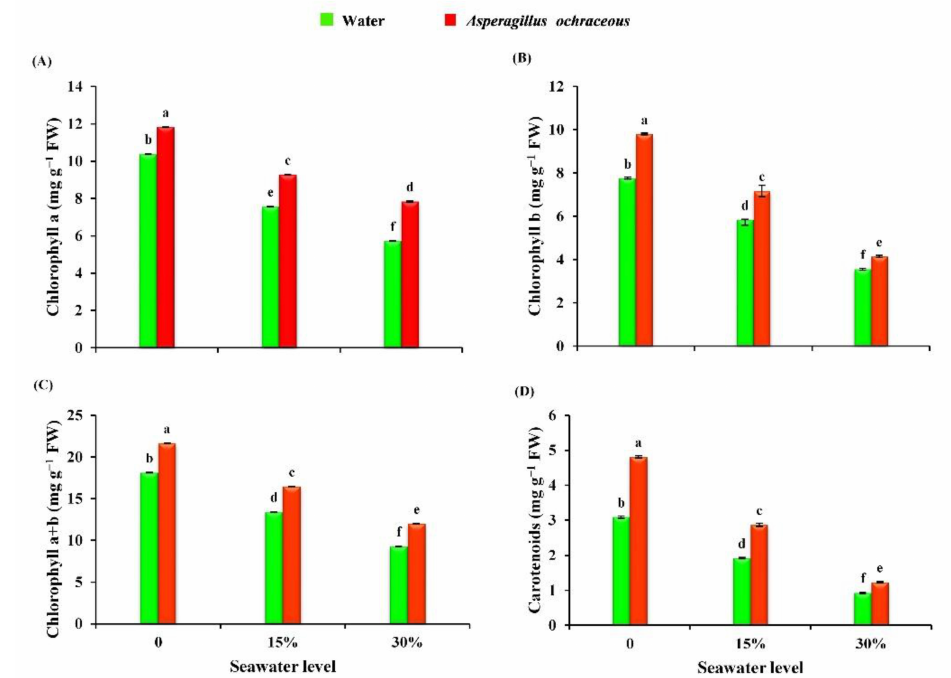
Figure 5. Effect of seawater irrigation, A. ochraceus application, and their interactions on leaf pigments of barley plants {( A ) chlorophyll a, ( B ) chlorophyll b, ( C ) chlorophyll a + b, and ( D ) carotenoids}. Each bar represents the mean ± standard error. Different letters indicate significant differences between the treatments according to an LSD test at p < 0.05. FW: fresh weight. Table 3. Effect of seawater irrigation, A. ochraceus application, and their interactions on soluble sugars, soluble proteins, and free proline contents (mg g − 1 DW) in barley plants. Each value represents the mean ± standard error. Different letters indicate significant differences between the treatments according to an LSD test at p < 0.05. DW: Dry weight, S.W.: Seawater. Treatments Soluble Sugars Soluble Protein Free Proline 0% S.W. 93.09 ± 2.96 b 44.89 ± 0.73 b 0.38 ± 0.01 d Salinity 15% S.W. 78.72 ± 0.90 d 0.88 ± 0.03 b 30% S.W. 70.65 ± 2.37 e 25.52 ± 0.57 f 1.00 ± 0.02 a 0% S.W. 104.08 ± 2.01 Salinity + A. ochraceus